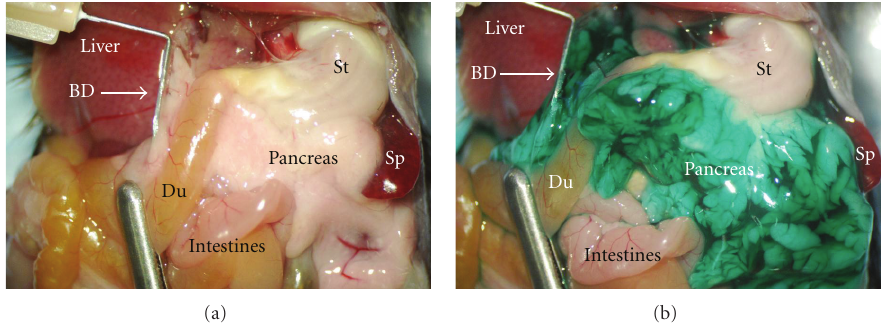
Figure 1: Distention of pancreas with collagenase solution. (a) Before injection of collagenase, a bulldog clamp (silver bar at bottom left) is placed around the duodenum (Du) and over the Papilla of Vater of the common bile duct to prevent drainage into the duodenum. The common bile duct (BD) is cannulated with angled hypodermic needle (upper left of picture) in preparation to su ff use pancreas with collagenase. The pancreas is the whitish mass between the spleen (Sp), stomach (St), liver, and intestines. (b) Same picture after inflation. A green vegetable dye is used here to visualize full distension of the